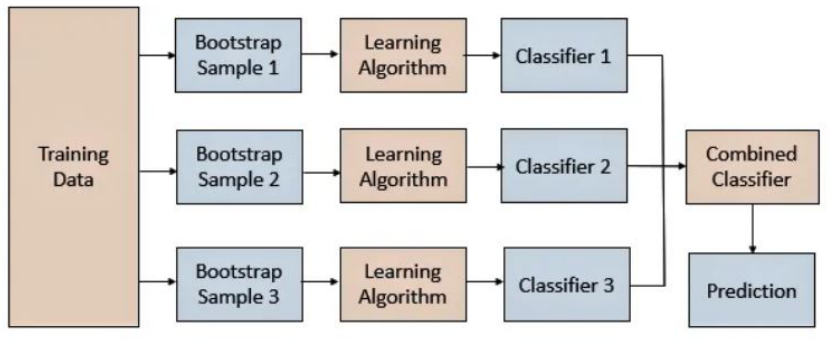
Figure 4. Explanation of Bootstrap Aggregating Method